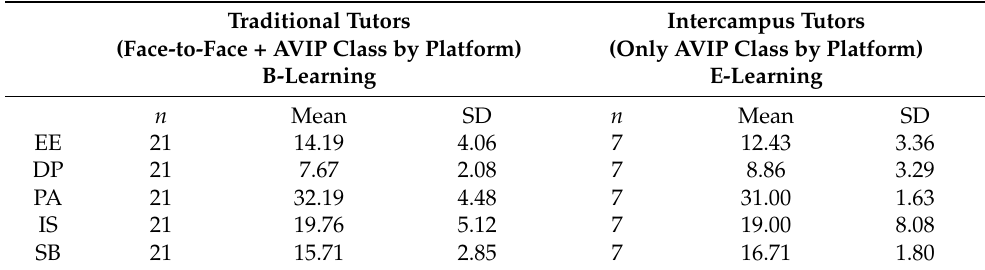
Table 5. Results of the dimensions by tutoring modality.